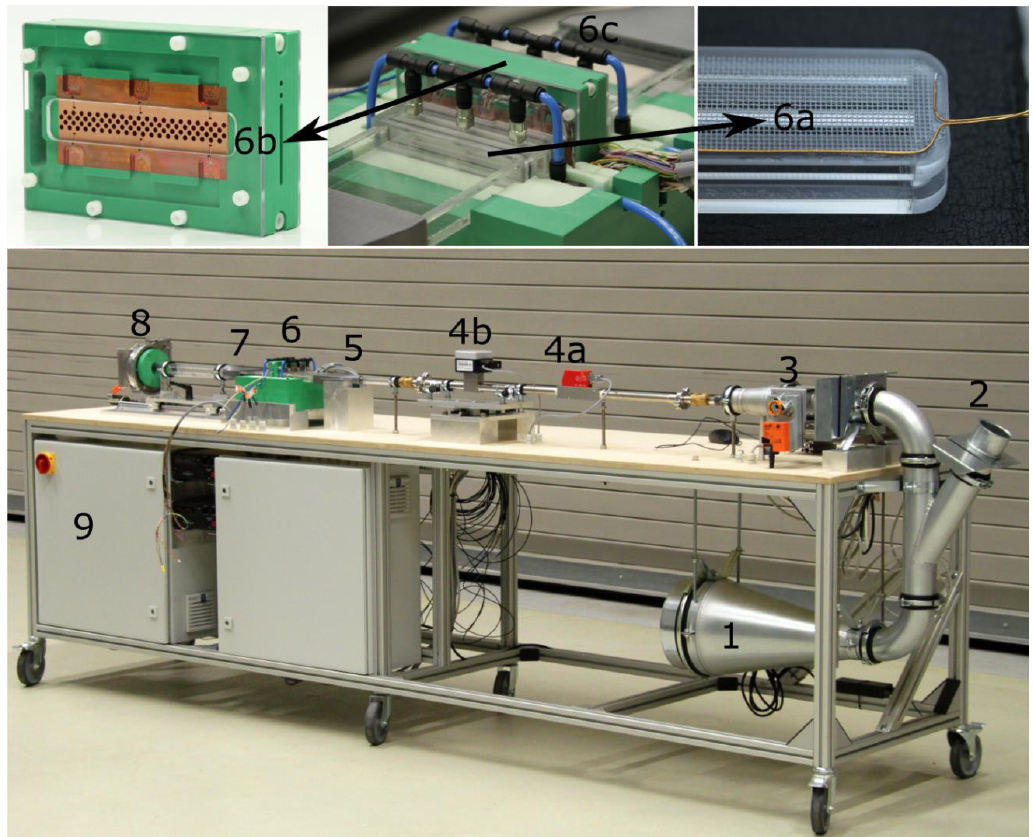
Figure 6. View of the test section and additional components; 1: preconditioned air inlet; 2: bypass; 3: throttle valve; 4a and b: mass flow rate sensors; 5: cross section adaption; 6: test sample enclosure; 6a: